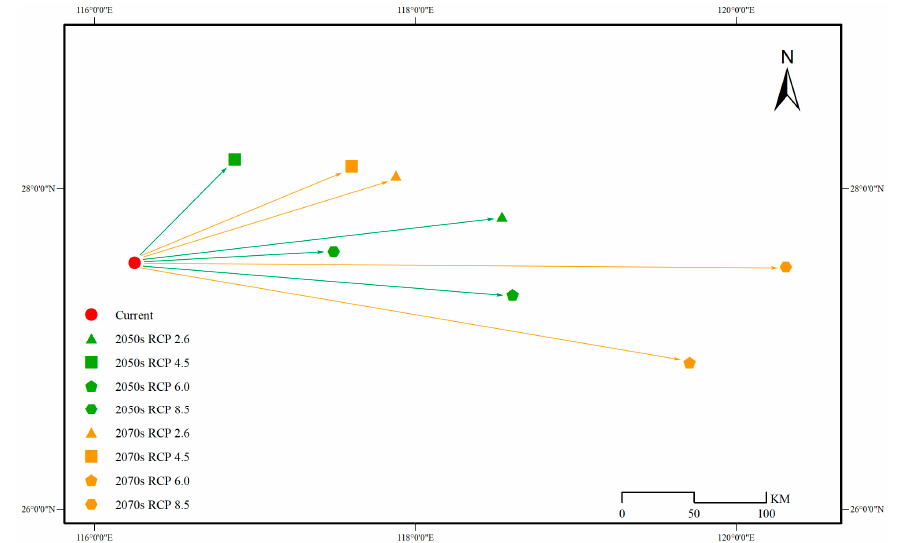
Figure 8. Centroid migration in the suitable distribution area of Carpinus tientaiensis under different climate scenarios. The arrow indicates the direction of change of the centroid of the suitable distribution area with time.